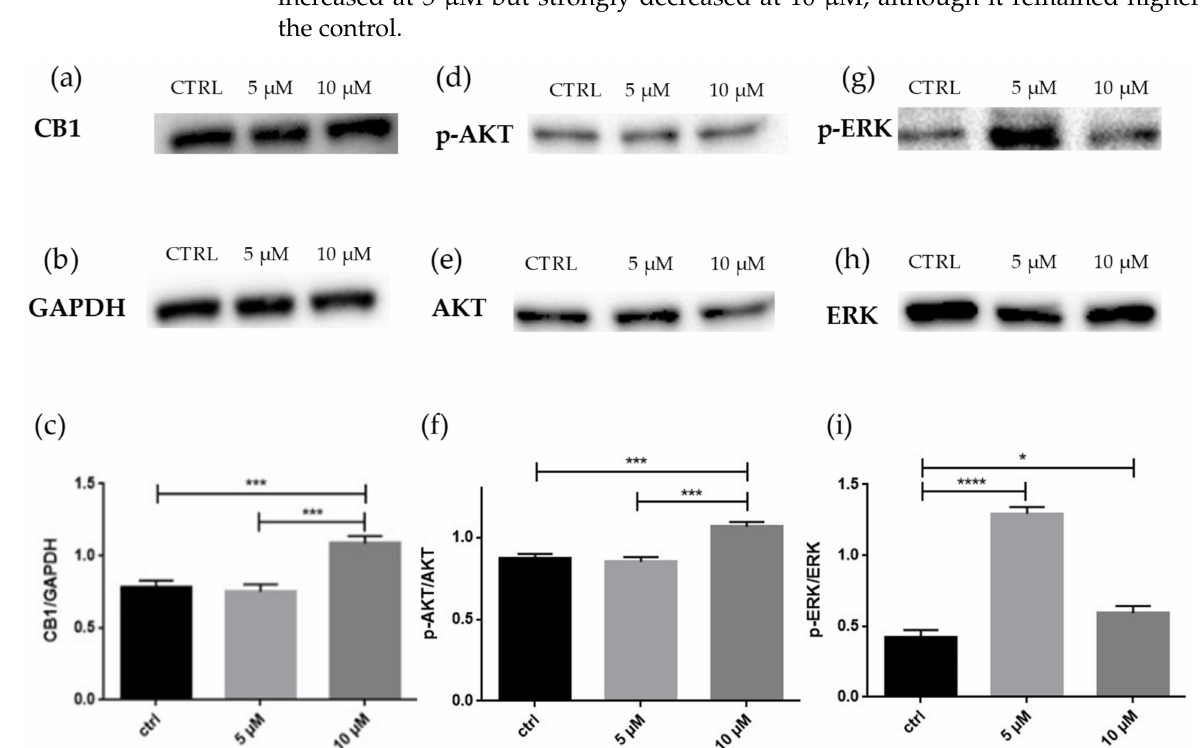
Figure 5. ( a ) Evidence of the significant increase of CB1 in NSC-34 after treatment with CBD at a high dose. ( b ) GAPDH used for normalization. ( c ) Densitometric analysis of CB1, *** p < 0.0005. ( d ) Evidence of phosphorylation of ATK at a high dose. ( e ) Non-phosphorylated AKT used for normalization. ( f ) Densitometric analysis of p-AKT, *** p < 0.0005. ( g ) Evidence of different phos- phorylation of ERK at two doses compared to the control. ( h ) Non-phosphorylated ERK used for normalization. ( i ) Densitometric analysis of p-ERK, * p < 0.05, **** p <